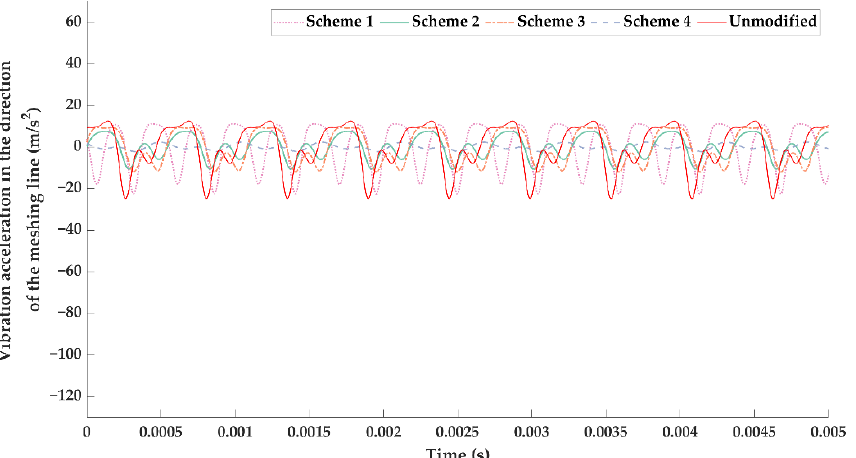
Figure 23. Vibration acceleration in the direction of the gear meshing line at a load of 250 N·m.